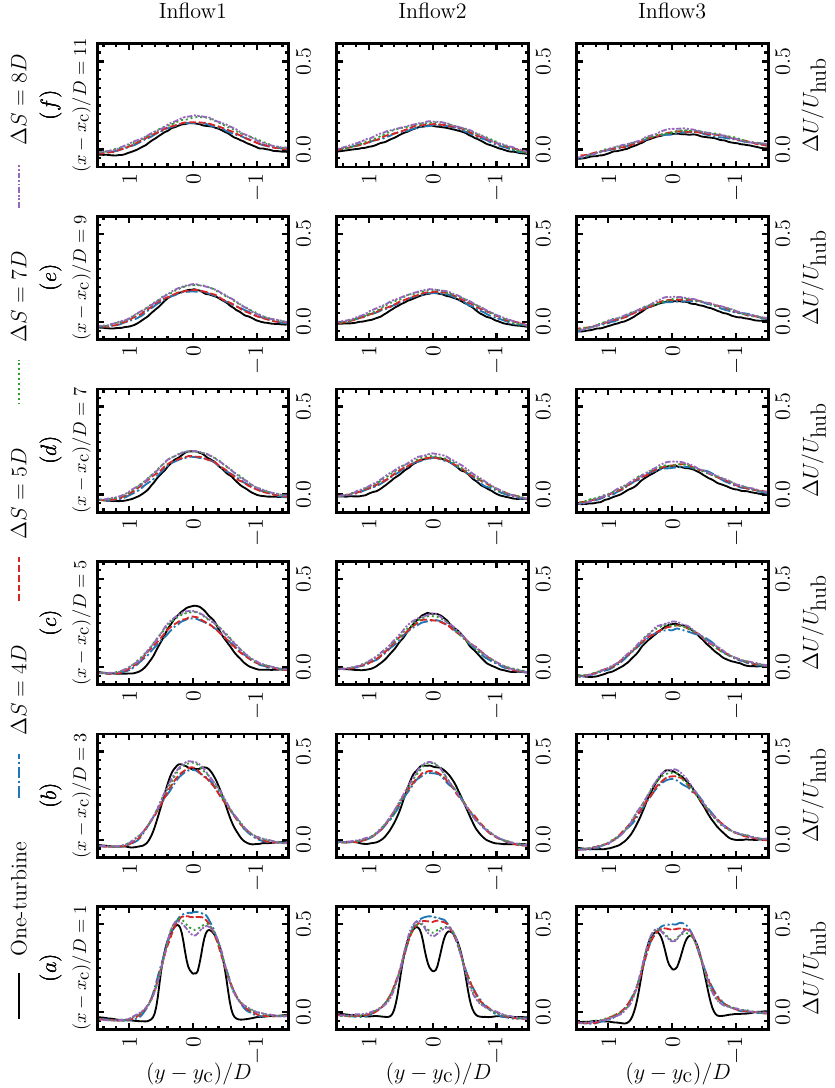
Figure 6. Spanwise profiles of the streamwise velocity deficits downwind of the second turbine of the two-turbine cases and downwind of the stand-alone turbine at ( a ) ( x ( e ) 9, ( f )